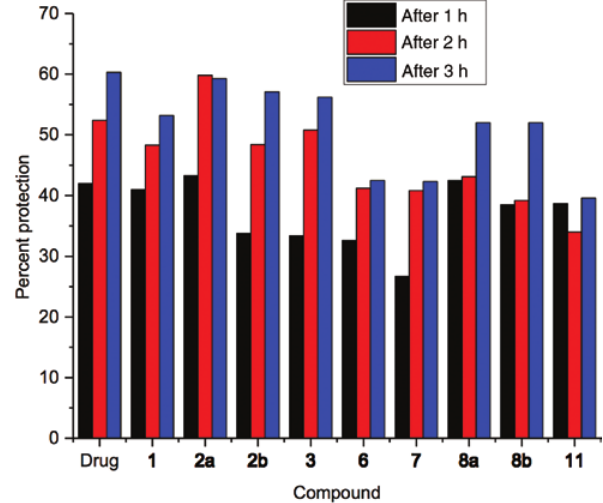
Figure 1: Erythrocyte hemolysis (%).